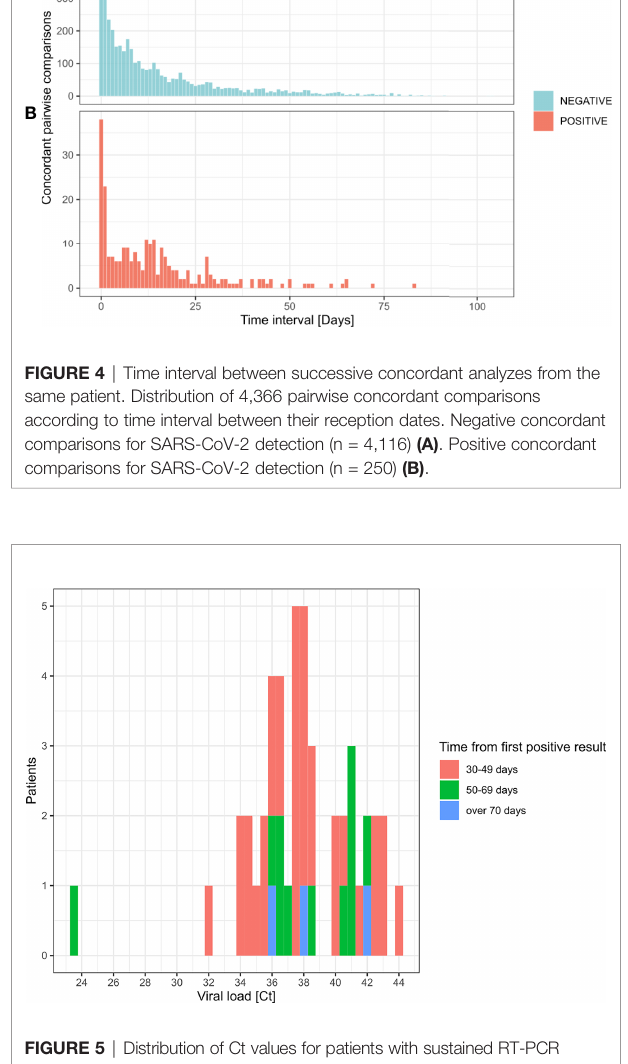
FIGURE 5 | Distribution of Ct values for patients with sustained RT-PCR positive results. This histogram represents the Ct value (maximal if more than 1) for SARS-CoV-2 detection by RT-PCR in the last positive sample of patients with sustained positivity in samples taken 30 days apart or more.